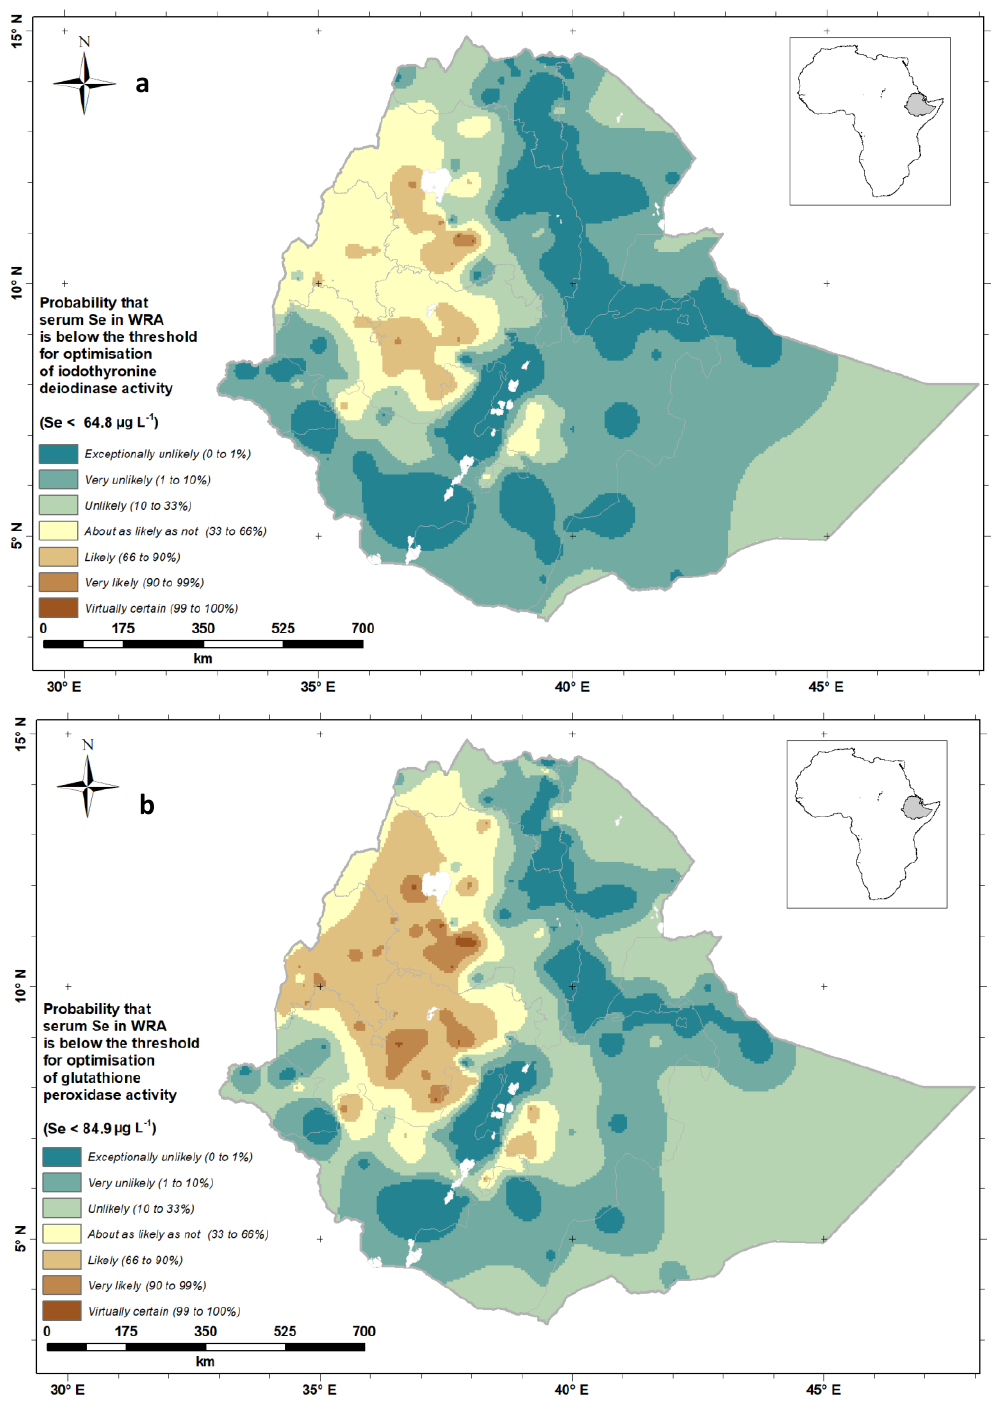
Figure 7. Probability that serum Se concentration of Ethiopian women of reproductive age would fall below a threshold for the optimal activity of ( a ) iodothyronine deiodinase (IDI), ( b ) glutathione peroxidase 3 (GPx3).